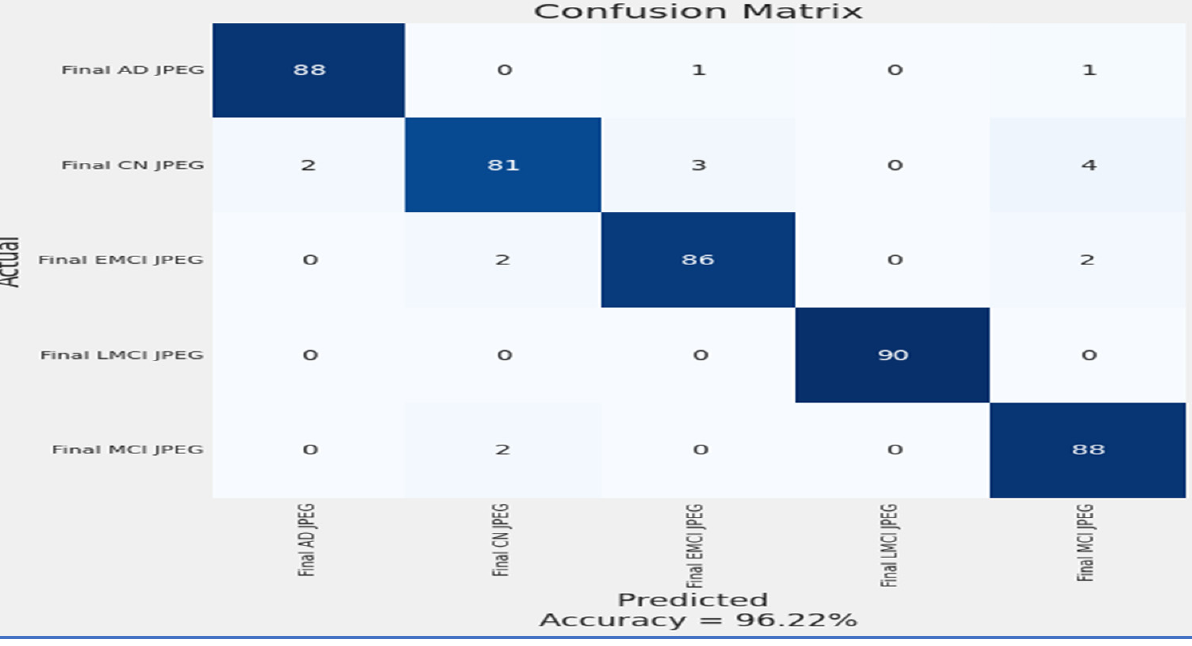
Figure 5. S hows the accuracy and loss values during training over 100 Epochs. The number of patients diagnosed with each type of AD stage (NC/MCI/AD/LMCI/EMCI) is shown in the confusion matrix. The normalized confusion